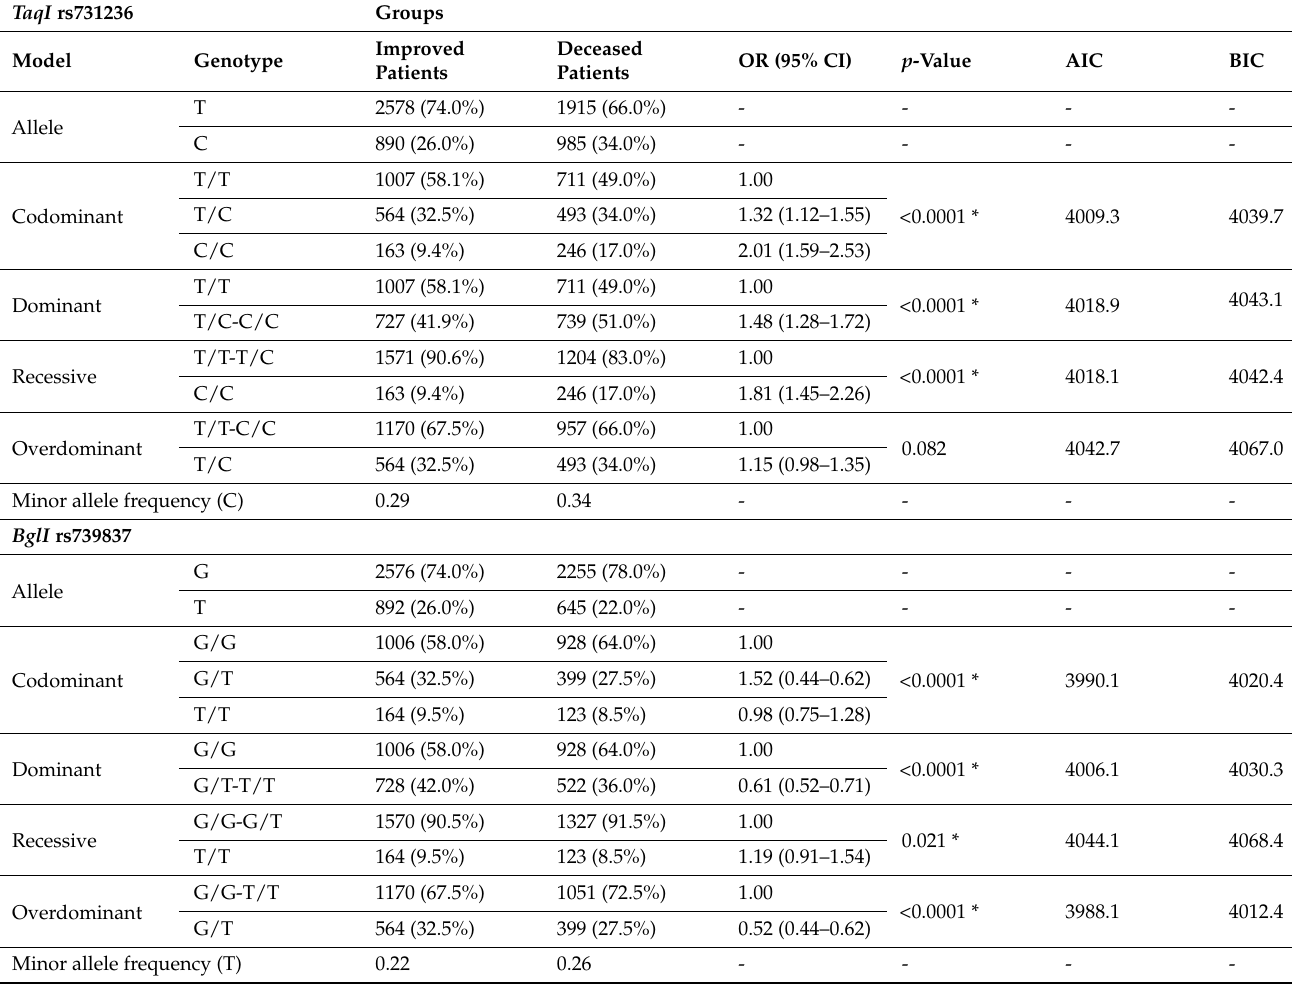
Table 2. TaqI rs731236 and BglI rs739837 polymorphisms association with COVID-19 mortality adjusted by SARS-CoV-2